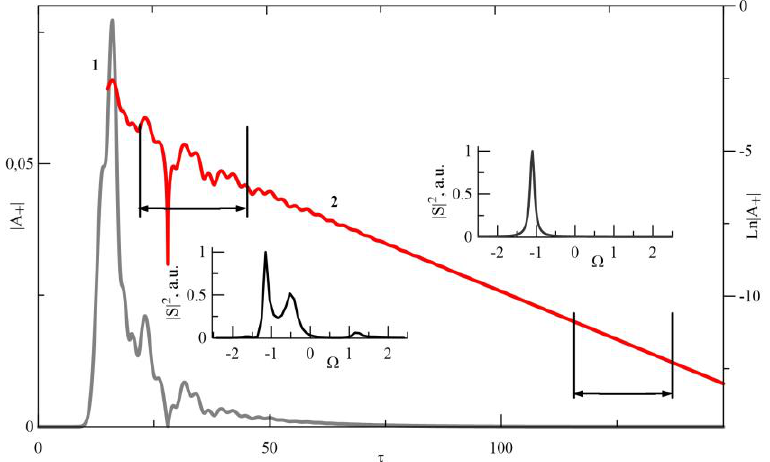
Fig. 2. Time dependence of the field amplitude in the process of excitation of Bragg resonator by external pulse and its subsequent decay (curve 1). Т he descending stage of above dependence in the logarithm scale (curve 2). Lower insert contains the field spectrum at the intermediate time interval: [20,45]  , and the upper one contains the spectrum at the final interval: [115,140]  , 5 8 L  , 1 N  x